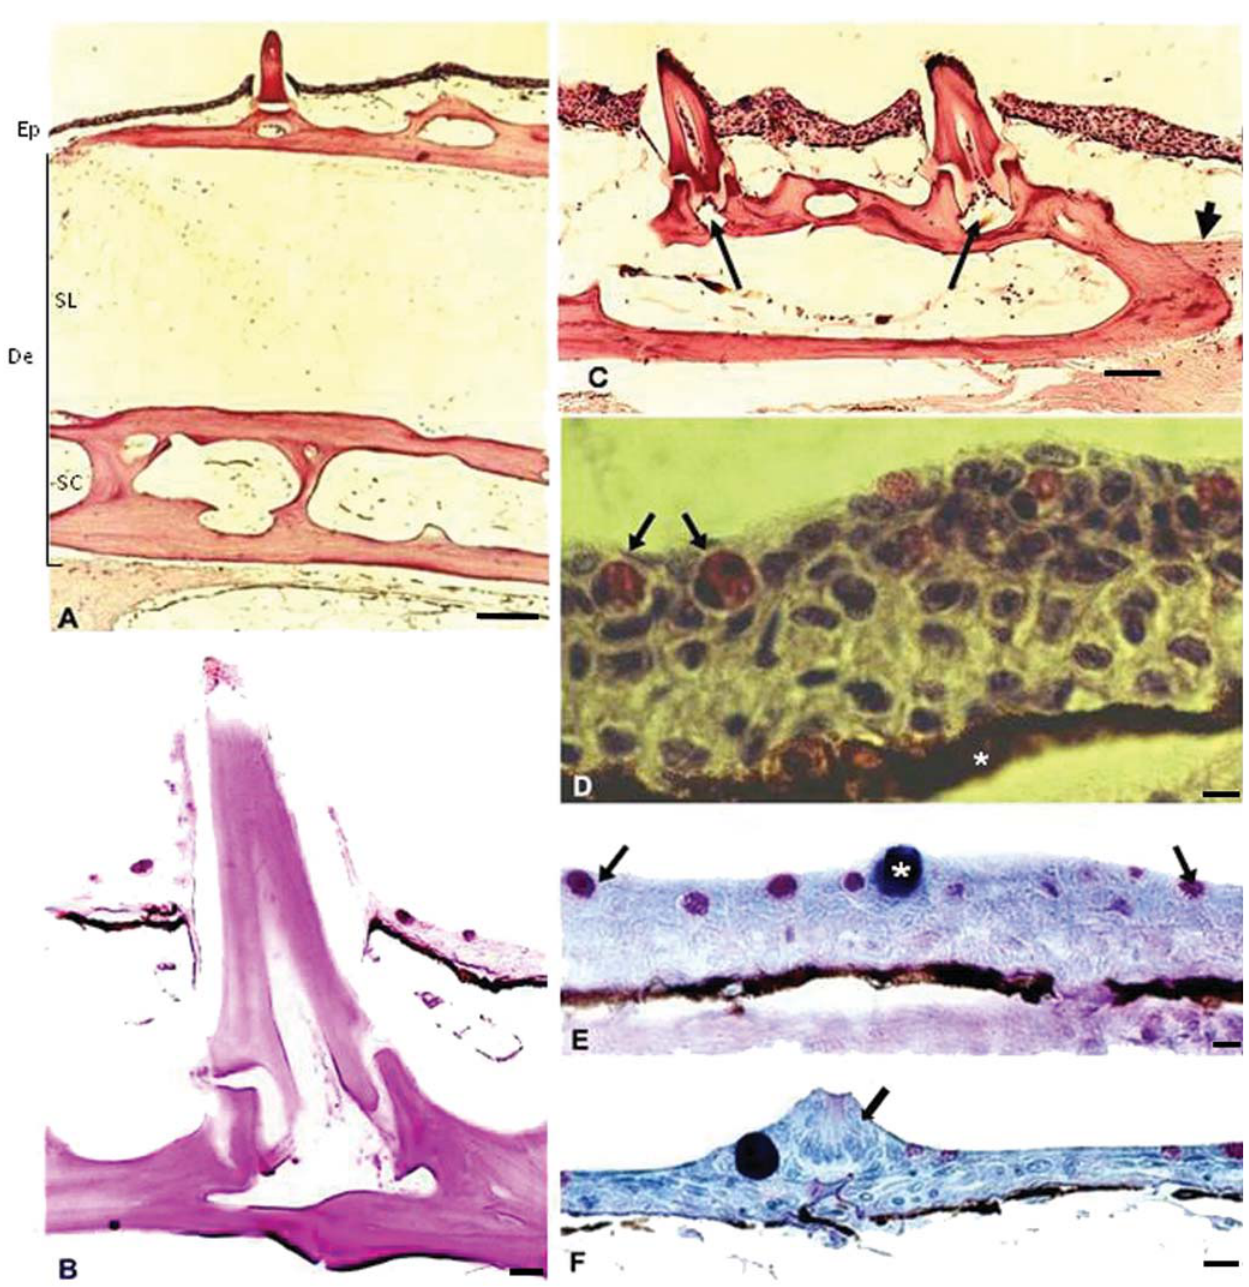
Fig. 1. Skin of Ancistrus dolichopterus . A ) Epidermis (Ep) and thick dermis (De) of A . dolichopterus showing stratum laxum (SL) and s tratum compactum (SC), note also the hollow osteoderm and the denticle (HE). Scale bar = 100 mm. B ) Denticle at higher magnification. (PAS) Scale bar = 10 mm. C ) Denticles with pointed crown and broad basal parts. The narrow pedestal basal part fit in the cup shaped structure of dermal osteoderm (arrows). The dentine surrounds the pulp cavity, filled with cells and connective tissue, and covered by a thin enamel layer. The osteoderm is connected with the denticles with attachment fibers (small arrows). (HE) Scale bar = 20 mm. D ) Epidermis showing epithelial cells distributed in different layers, low columnar cells in basal, polygonal in the middle and flat cells in the superficial layer. Spherical eosinophilic granular cells (arrows) with granular cytoplasmic contents and eccentric nucleus. Note the pigment cells with dark brown coarse granules (*) in a continuous layer below the basement membrane (HE). Scale bar = 10 mm. E ) General glycoproteins in the epidermis. The mucous cell (*) and EGCs (arrows) stain very strong while epithelial cells located in superficial and outer middle layers stain moderately (AB/PAS). Scale bar = 10 mm. F ) A pear shaped taste bud (arrow) (AB/PAS) Scale bar = 10